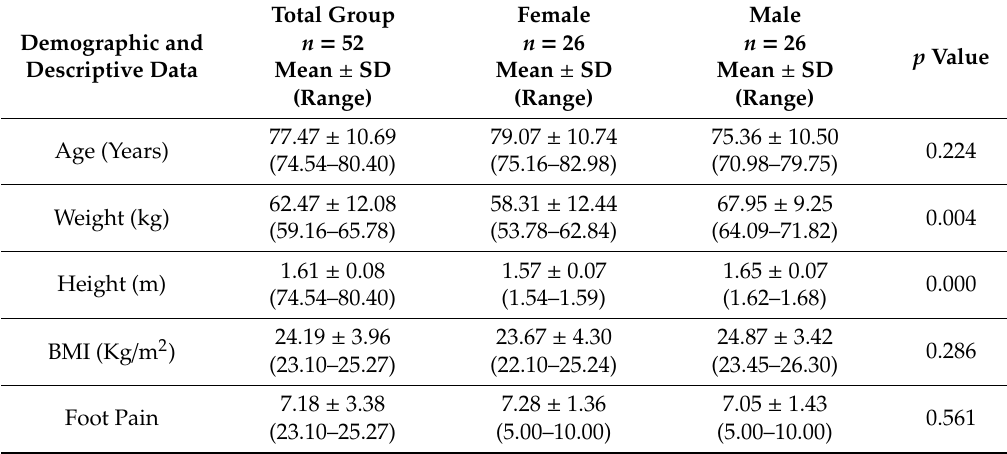
Table 1. Descriptive and socio-demographic data of the